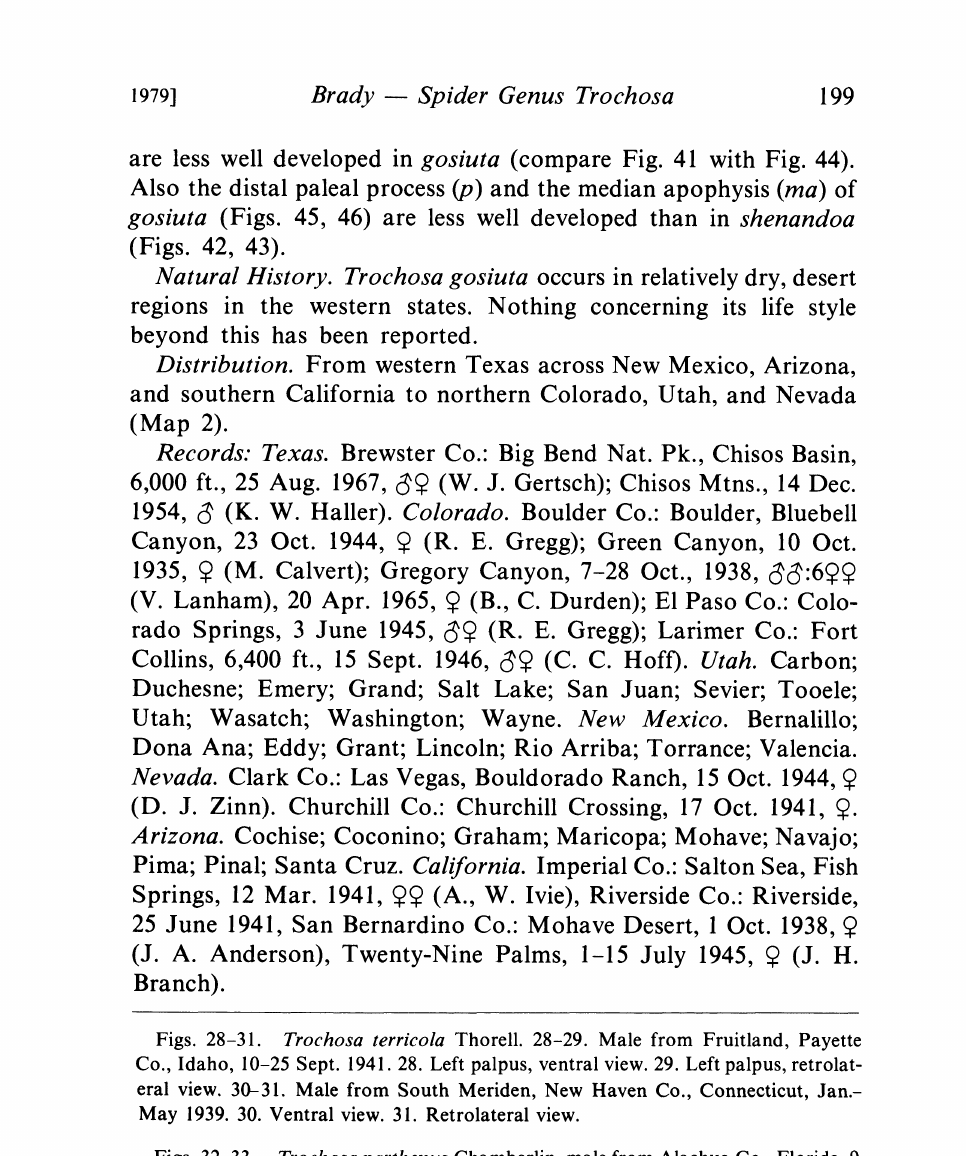
Figs. 28-31. Trochosa terricola Thorell. 28-29. Male from Fruitland, Payette Co., Idaho, 10-25 Sept. 1941.28. Left palpus, ventral view. 29. Left palpus, retrolat- eral view. 30-31. Male from South Meriden, New Haven Co., Connecticut, Jan.- May 1939. 30. Ventral view. 31. Retrolateral view. Figs. 32-33. Trochosaparthenus Chamberlin, male from Alachua Co., Florida, 9 Nov. 1928. 32. Left palpus, retrolateral view. 33. Ventral view. Figs. 34-35. Trochosa shenandoa Chamberlin and Ivie, male from Beaufort, Carteret Co., North Carolina, 25 Jan. 1952.34. Ventral view. 35. Retrolateral view. Figs. 36-37. Trochosa avara Keyserling, male from Ramsey, Bergen Co., New Jersey, 24 Sept. 1934. 36. Ventral view. 37. Retrolateral view. e,